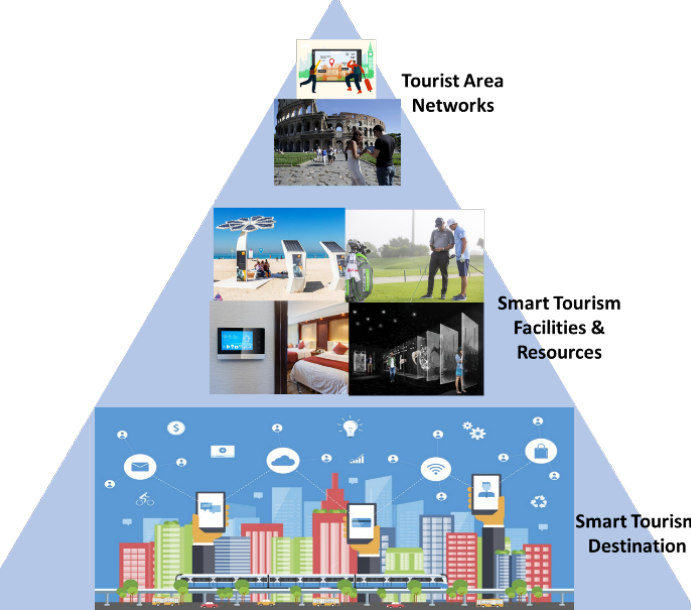
Figure 2. Application scenarios for ICT in the tourist